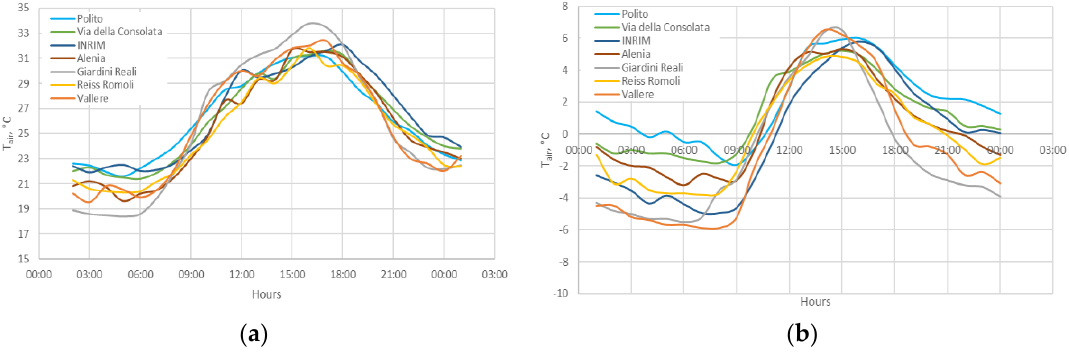
Figure 6. Hourly air temperatures of the seven WS measurements: ( a )25 August 2016; ( b )25 January Figure6. HourlyairtemperaturesofthesevenWSmeasurements: ( a )25August2016; ( b 2016.